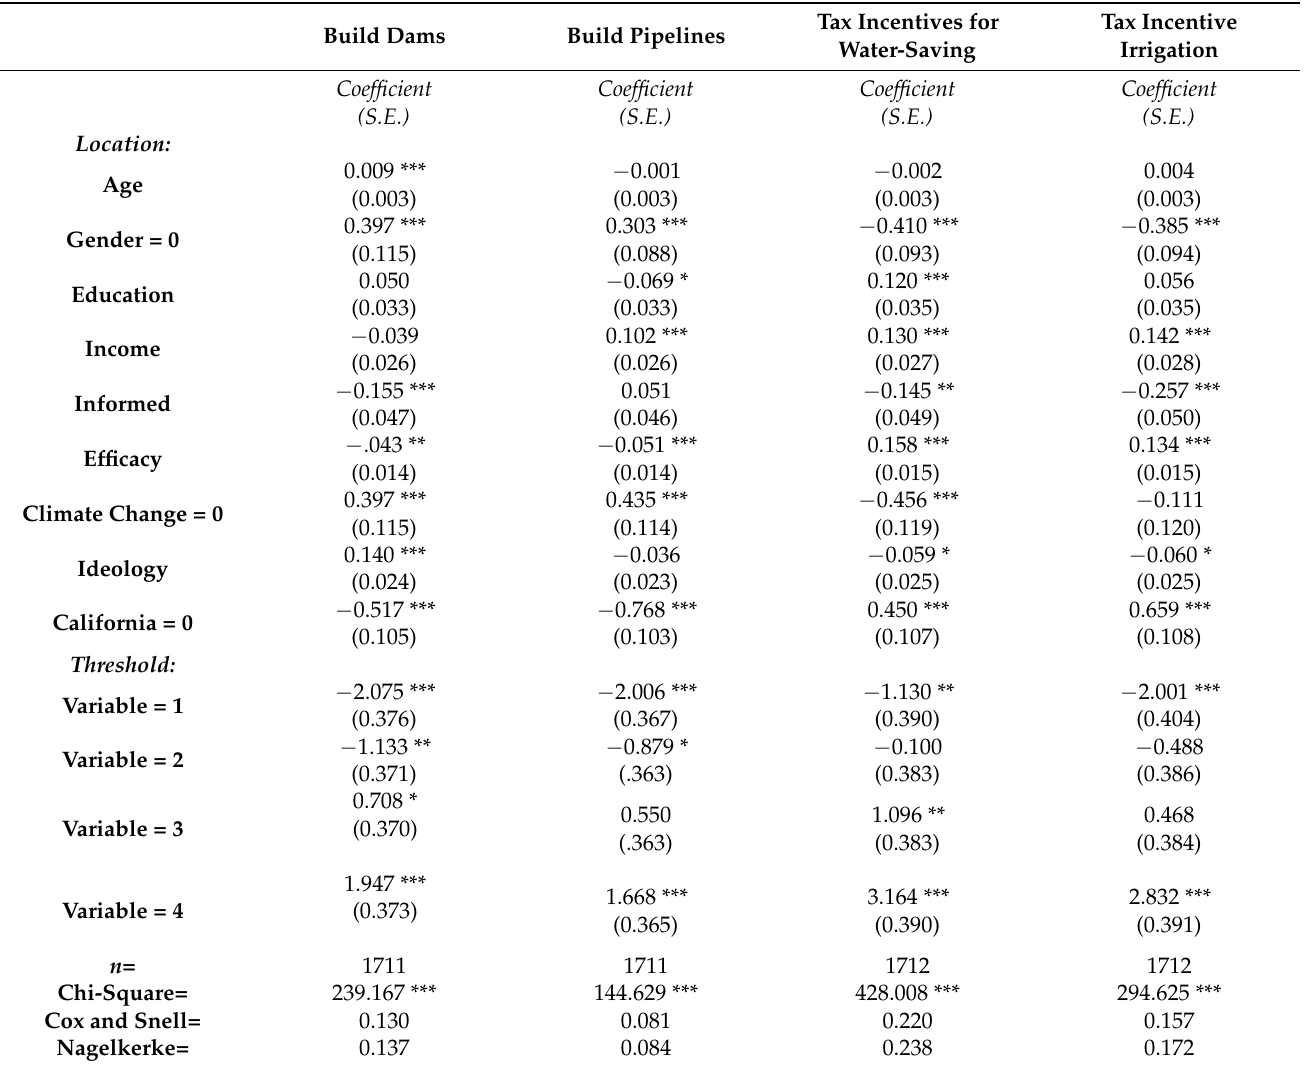
Table 4. Ordinal Regression Estimates for Water Infrastructure and Tax Incentive Policy